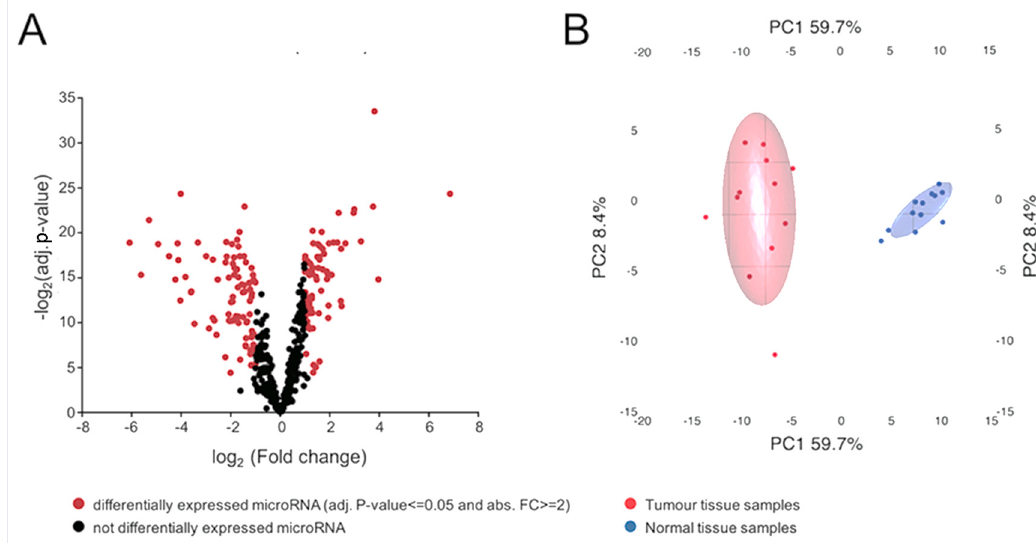
Figure 1. ( A ) Volcano plot of all detected miRNAs. From a total of 730 detected miRNAs, 182 were differentially expressed. Of all detected miRNAs, 423 were upregulated and 307 were downregulated in tumor samples. Among the differentially expressed miRNAs, 103 were downregulated and 79 were upregulated; ( B ) principal component analysis of the 182 differentially expressed miRNAs (those with an adjusted p -value < 0.05 and absolute fold change > 2). Samples segregate according to their diagnosis, with larger variation found amongst tumour tissue samples, as shown by the larger spread in that group, particularly along principal component 2.